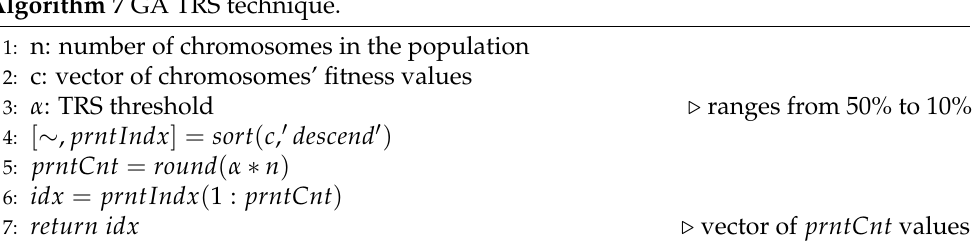
Algorithm 7 GA TRS